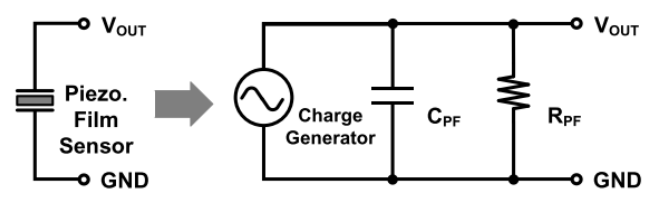
Figure 4. The equivalent circuity of the piezoelectric sensor [13] .